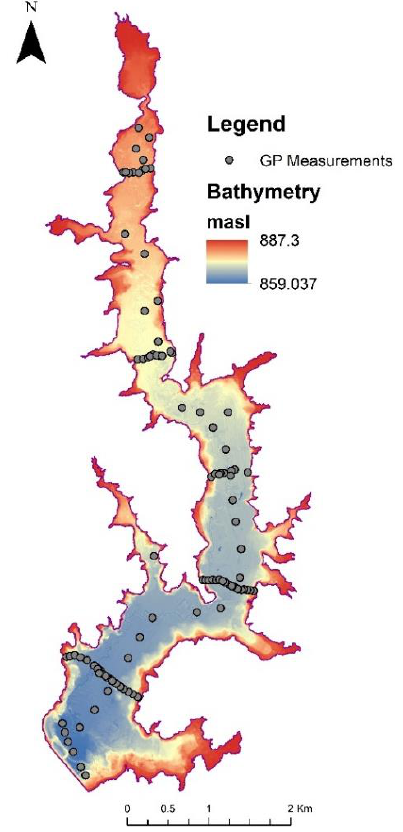
Figure 9. Location of all GP measurements.